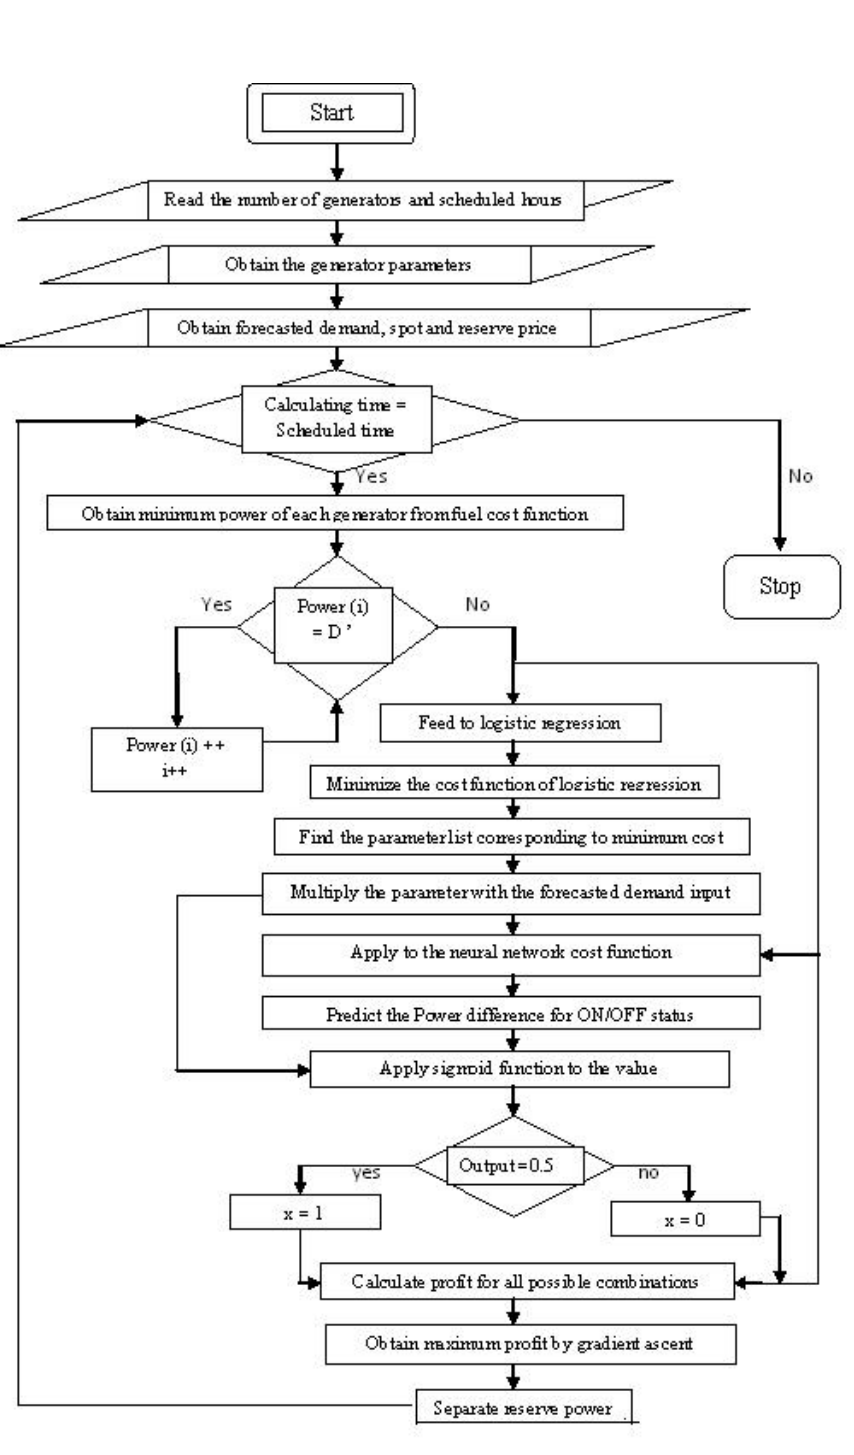
Fig 1.Flow Chart of proposed